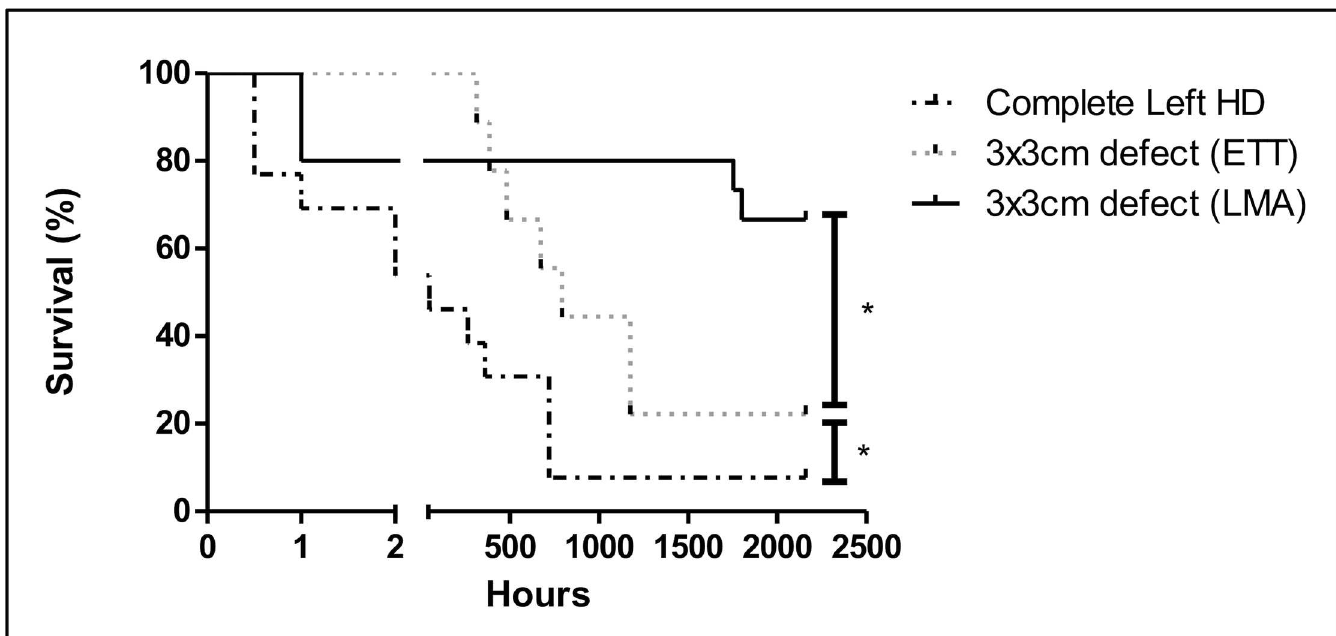
Fig 2. Survival curves. Followinga subtotal diaphragmatic excision,a 3 * 3cmdefect with endotracheal intubationand a 3 * 3cmdefect with laryngeal mask airway insertion; all defects were closed with a 3,5 * 3,5cmGore-Tex patch * p < 0.05.